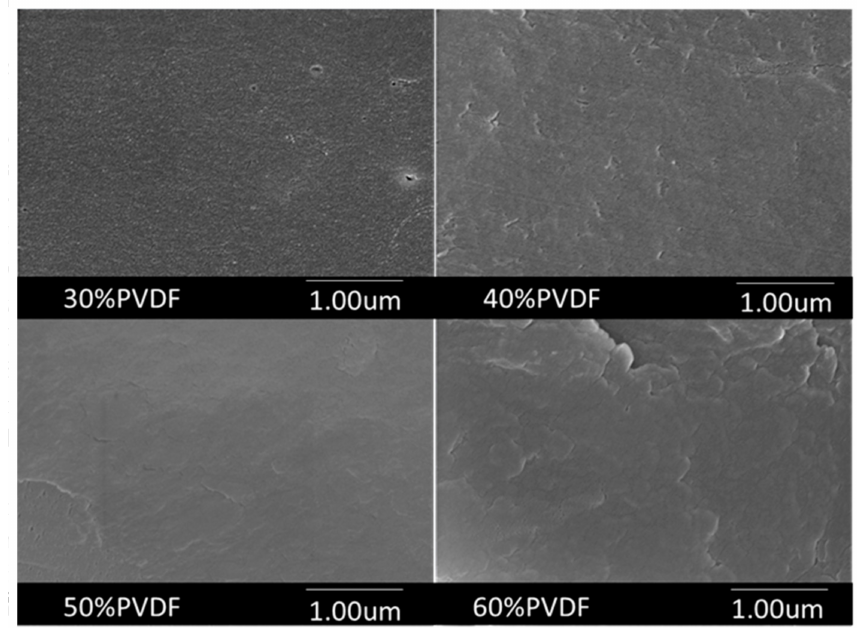
Figure 4. The cross-section SEM images of the s -PI-PVDF composite membranes.